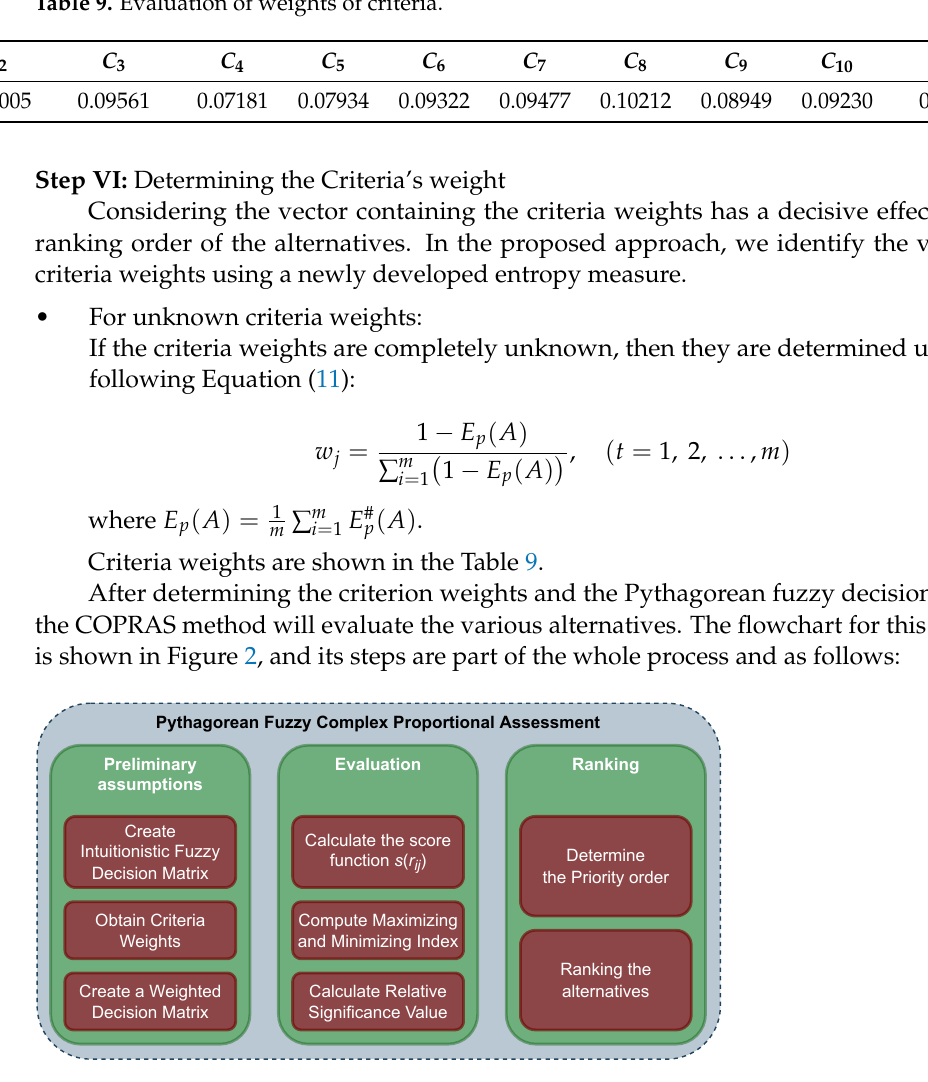
Figure 2. Flowchart of COPRAS